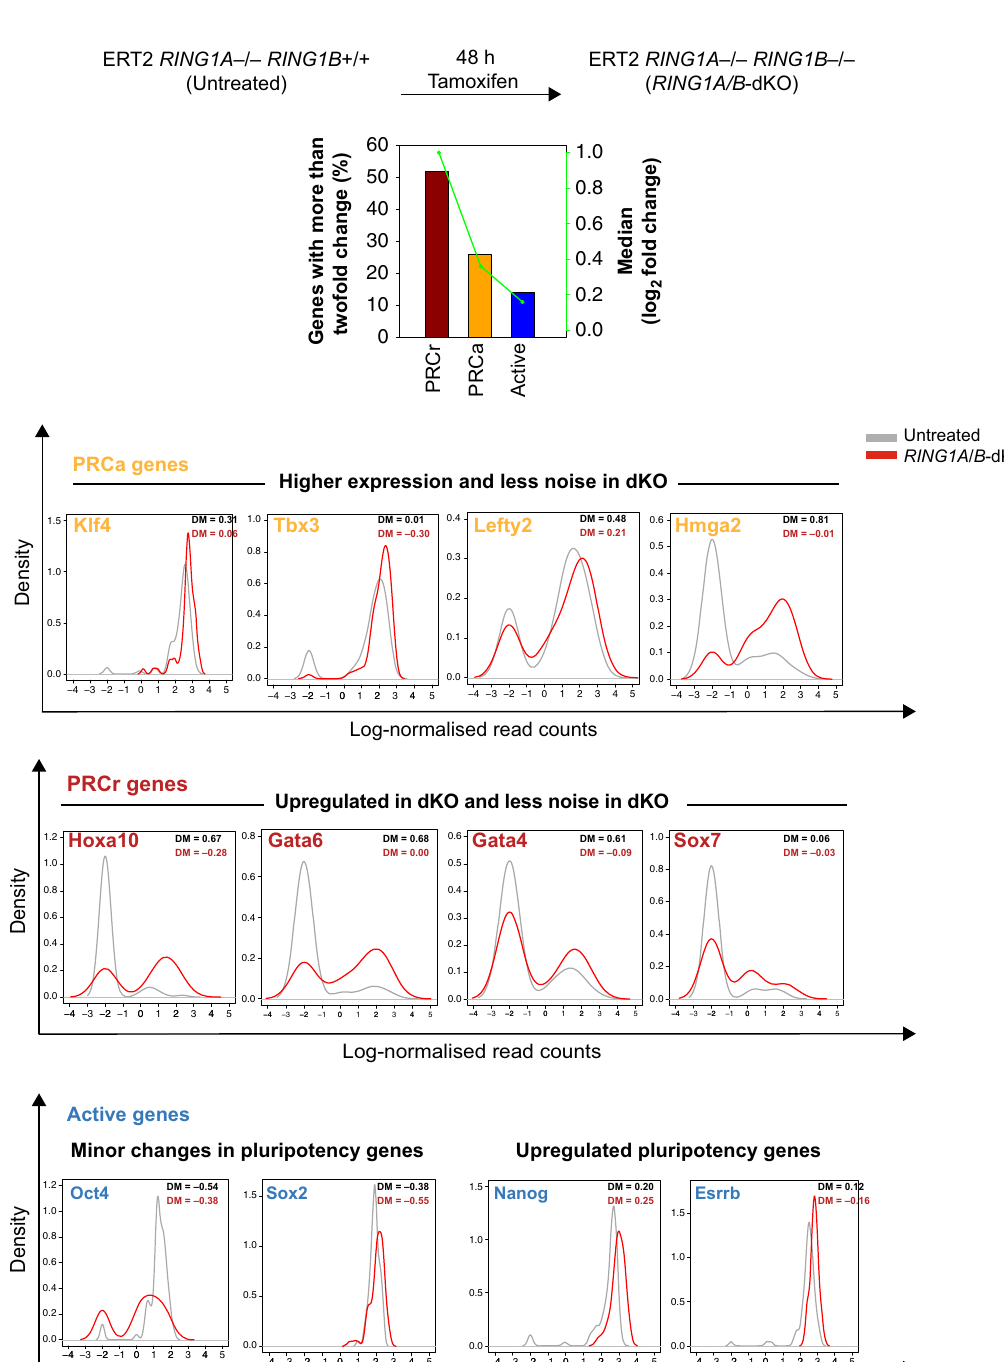
Fig. 6 Single-cell pro fi ling of Ring1A/B dKO mES cells ’ . PRCr show substantial derepression after Ring1A/B dKO. The mean expression change at PRCa genes is lower than that at PRCr and, in contrast, is higher than that at active genes. Comparison of noise levels shows that there is a more pronounced decrease in noise levels at PRCa genes compared to active genes. Gene expression pro fi les of some important genes for ESC biology are shown. Key pluripotency transcription factors Klf4 and Tbx3 are more expressed and less noisy in Ring1A/B dKO cells. Other transcriptional regulators such as Hmga2 and Hdac2 become upregulated after dKO. Consistently, key differentiation markers such as Gata4 , Gata6 are upregulated. Among active pluripotency factors, Oct4 and Sox2 show minor changes in expression (mean expression levels are not signi fi cantly different), and Nanog and Esrrb are